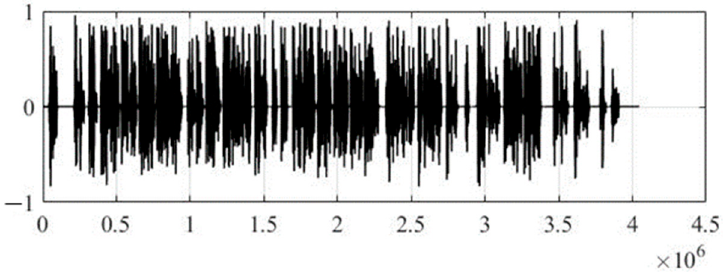
Figure 4. Original audio signal.